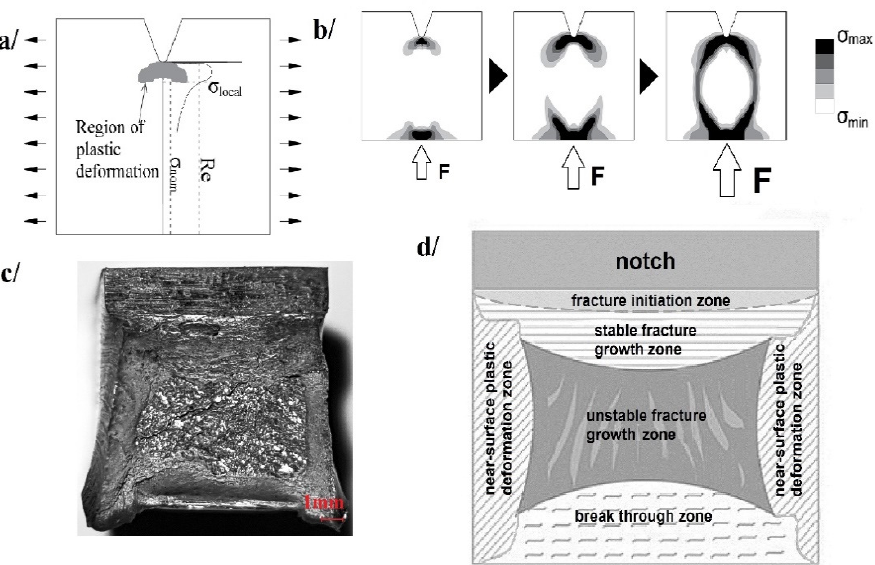
Figure 3. Notch effect on an ISO Charpy V steel sample: ( a ) local concentration of stresses under the notch crest as a result of pendulum strike, ( b ) numerical simulation of stress field development in a broken specimen, ( c ) typical fracture of mixed character, ( d ) identification of zones on the mixed fracture.